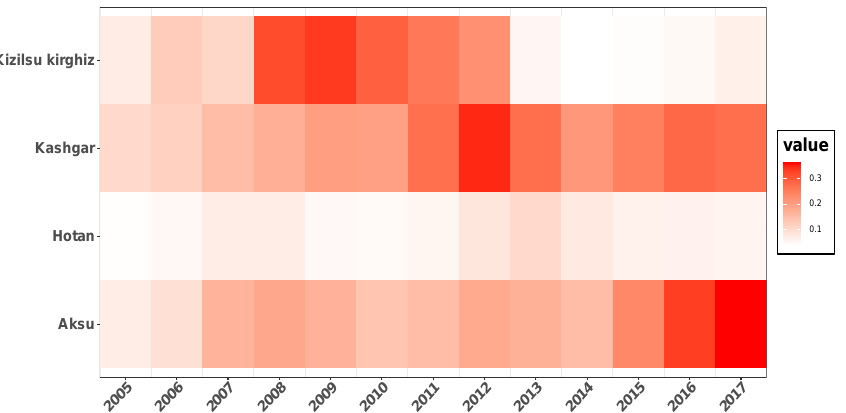
Figure 6. Incidence of HB among women over 35 years of age in four regions of Xinjiang from 2005 to 2017 (%).